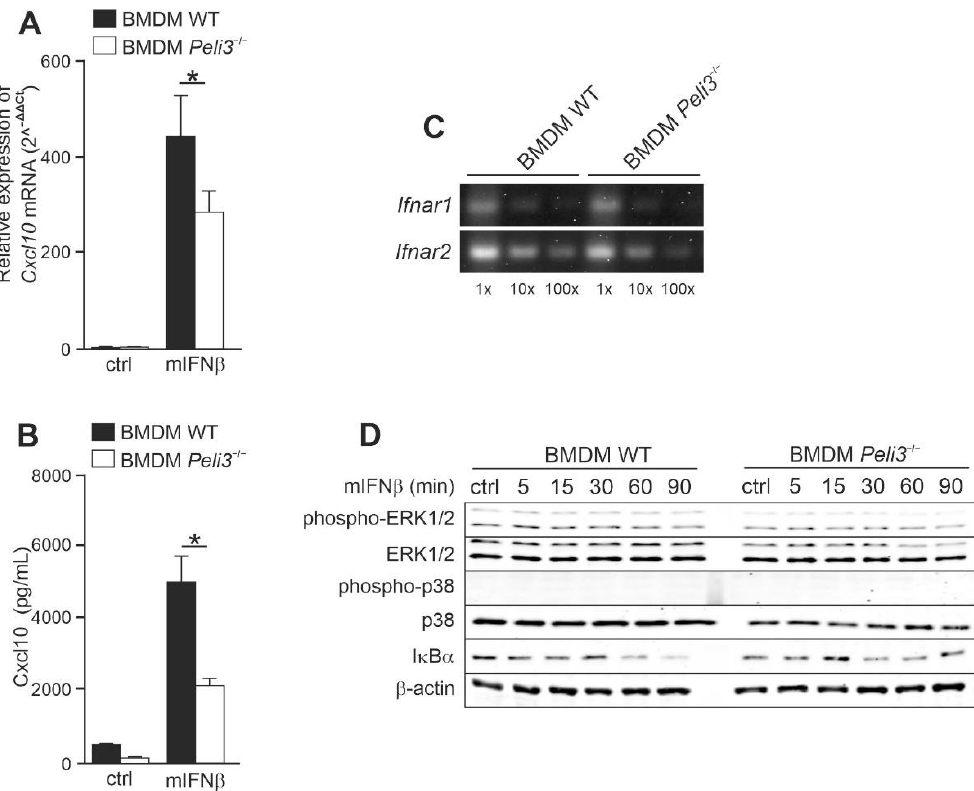
Figure 5. Pellino3 regulates IFNβ -induced Cxcl10 production in murine macrophages cell line, BMDM. Wild type (WT) and Peli3 −/− BMDM cells were treated with m IFNβ (mouse IFN β ) (50 ng/mL)